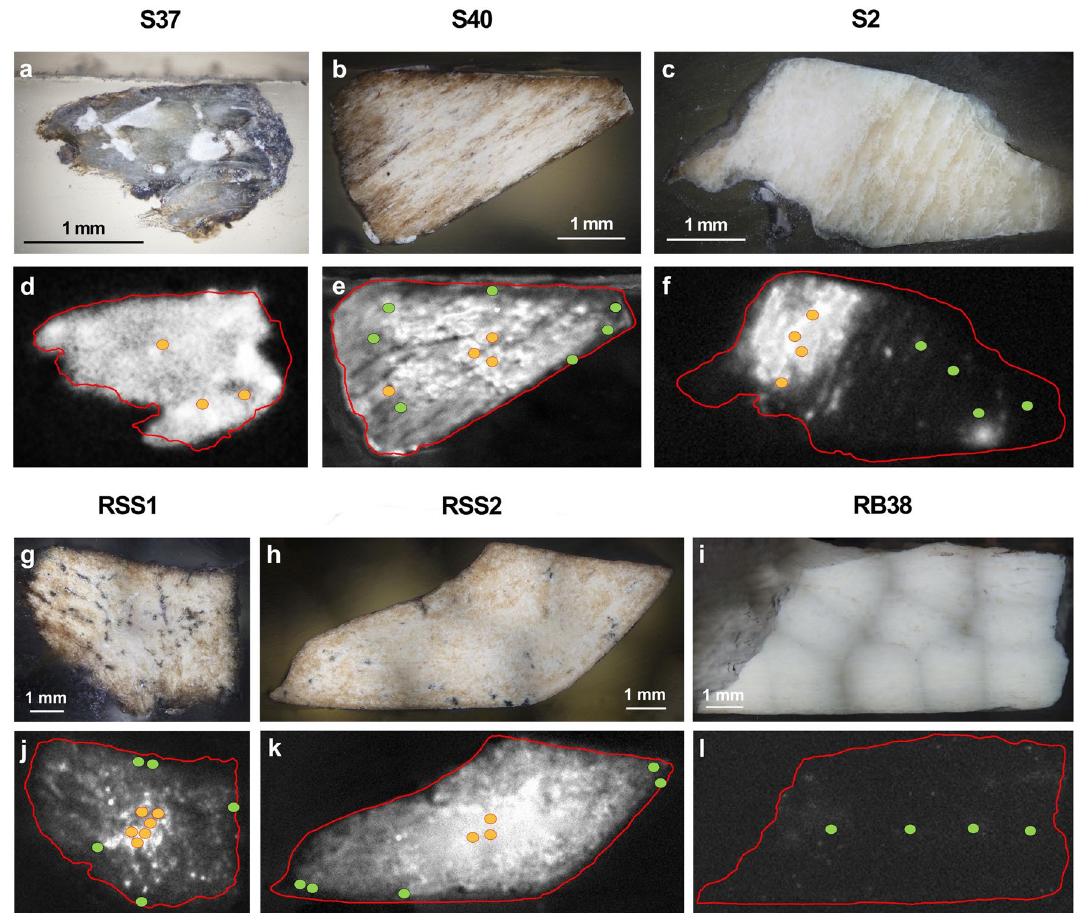
Figure 4. Optical microscope (top) and CL (bottom) images of investigated archeological faunal bone samples with known age and provenance (Table 1): ( a , d ) sample S37 (5 × magnification, outer surface is on the top and the inner part is down), ( b , e ) sample S40 (1.25 × magnification, outer surface is on the top and the inner part is down), ( c , f ) sample S2 (1.25 × magnification, inner surface is on the top and the outer part is down), ( g , j ) sample RSS1 (1.25 × magnification, inner surface is on the top and the outer part is down), ( h , k ) sample RSS2 (1.25 × magnification, inner surface is on the top and the outer part is down), ( i , l ) sample RB38 (1.25 × magnification, inner surface is on the top and the outer part is down). LA–ICP–MS points of analysis are showed in CL images placed in “high” (orange) and “low” (green) collagen content